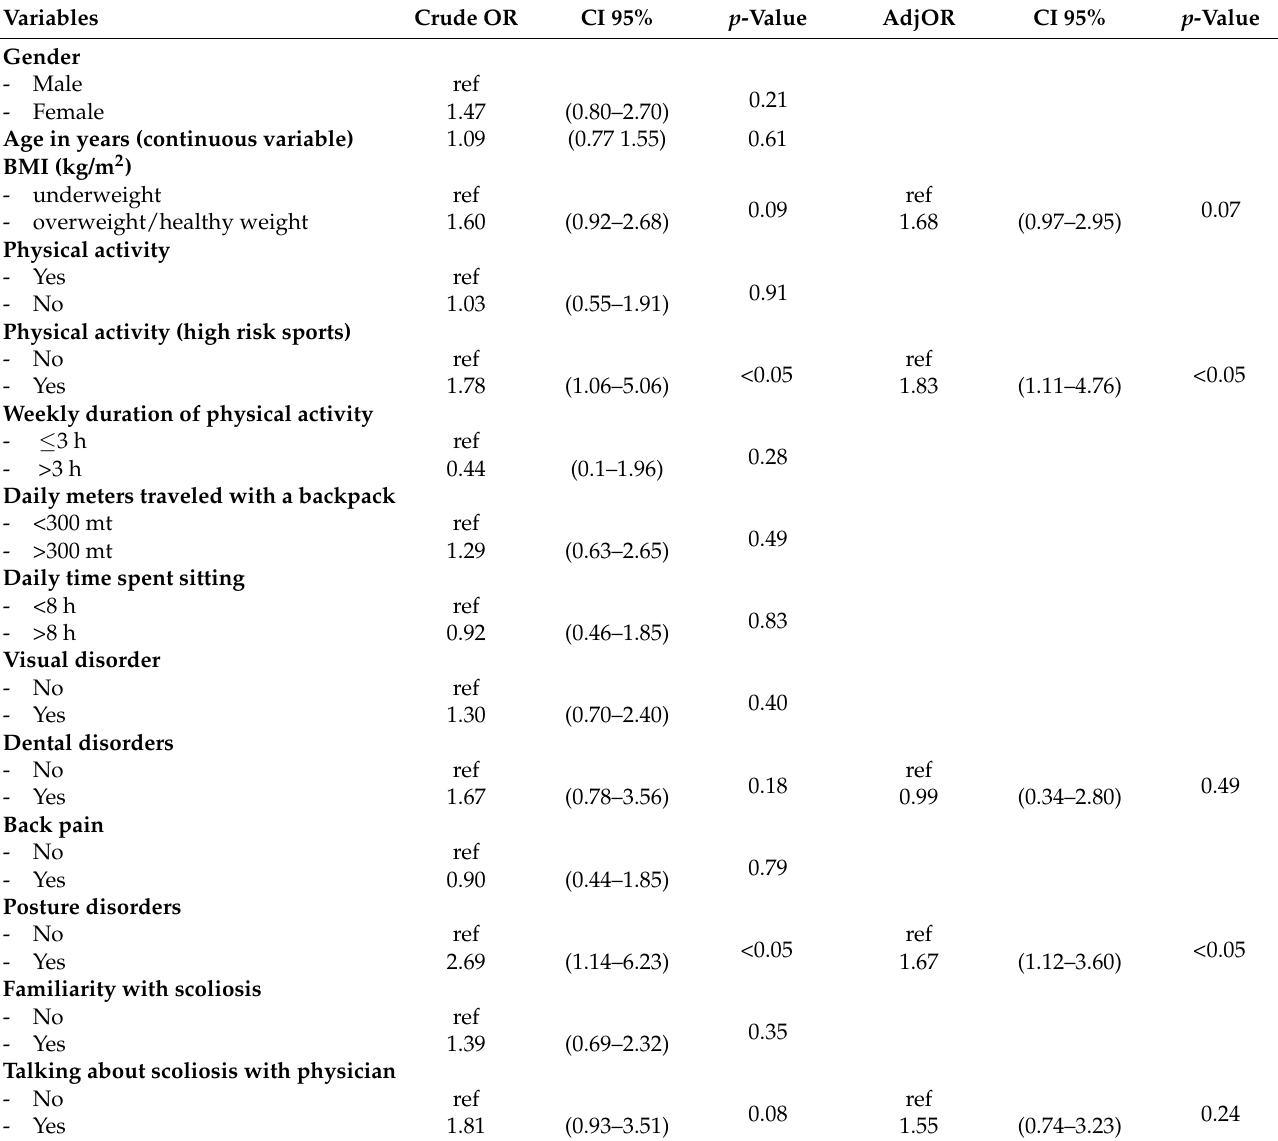
Table 3. Crude ORs and adjORs of variables (socio-demographic, daily personal habit, attitudes, clinical characteristics of students) associated with confirmed diagnosis of scoliosis (Cobb angle ≥ 10 ◦ at